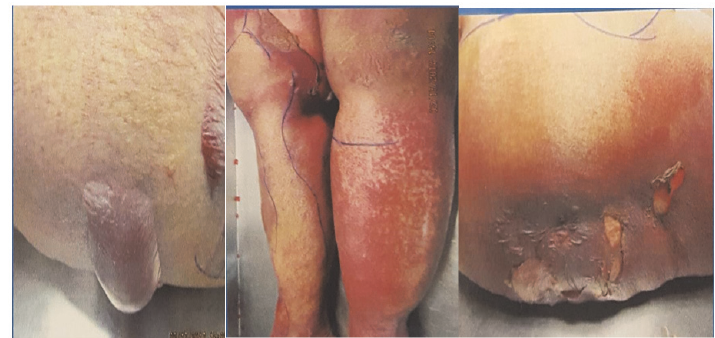
Figure 1: Rash on the back with bullae, rash on the posterior aspect of legs, and desquamating rash on the back.